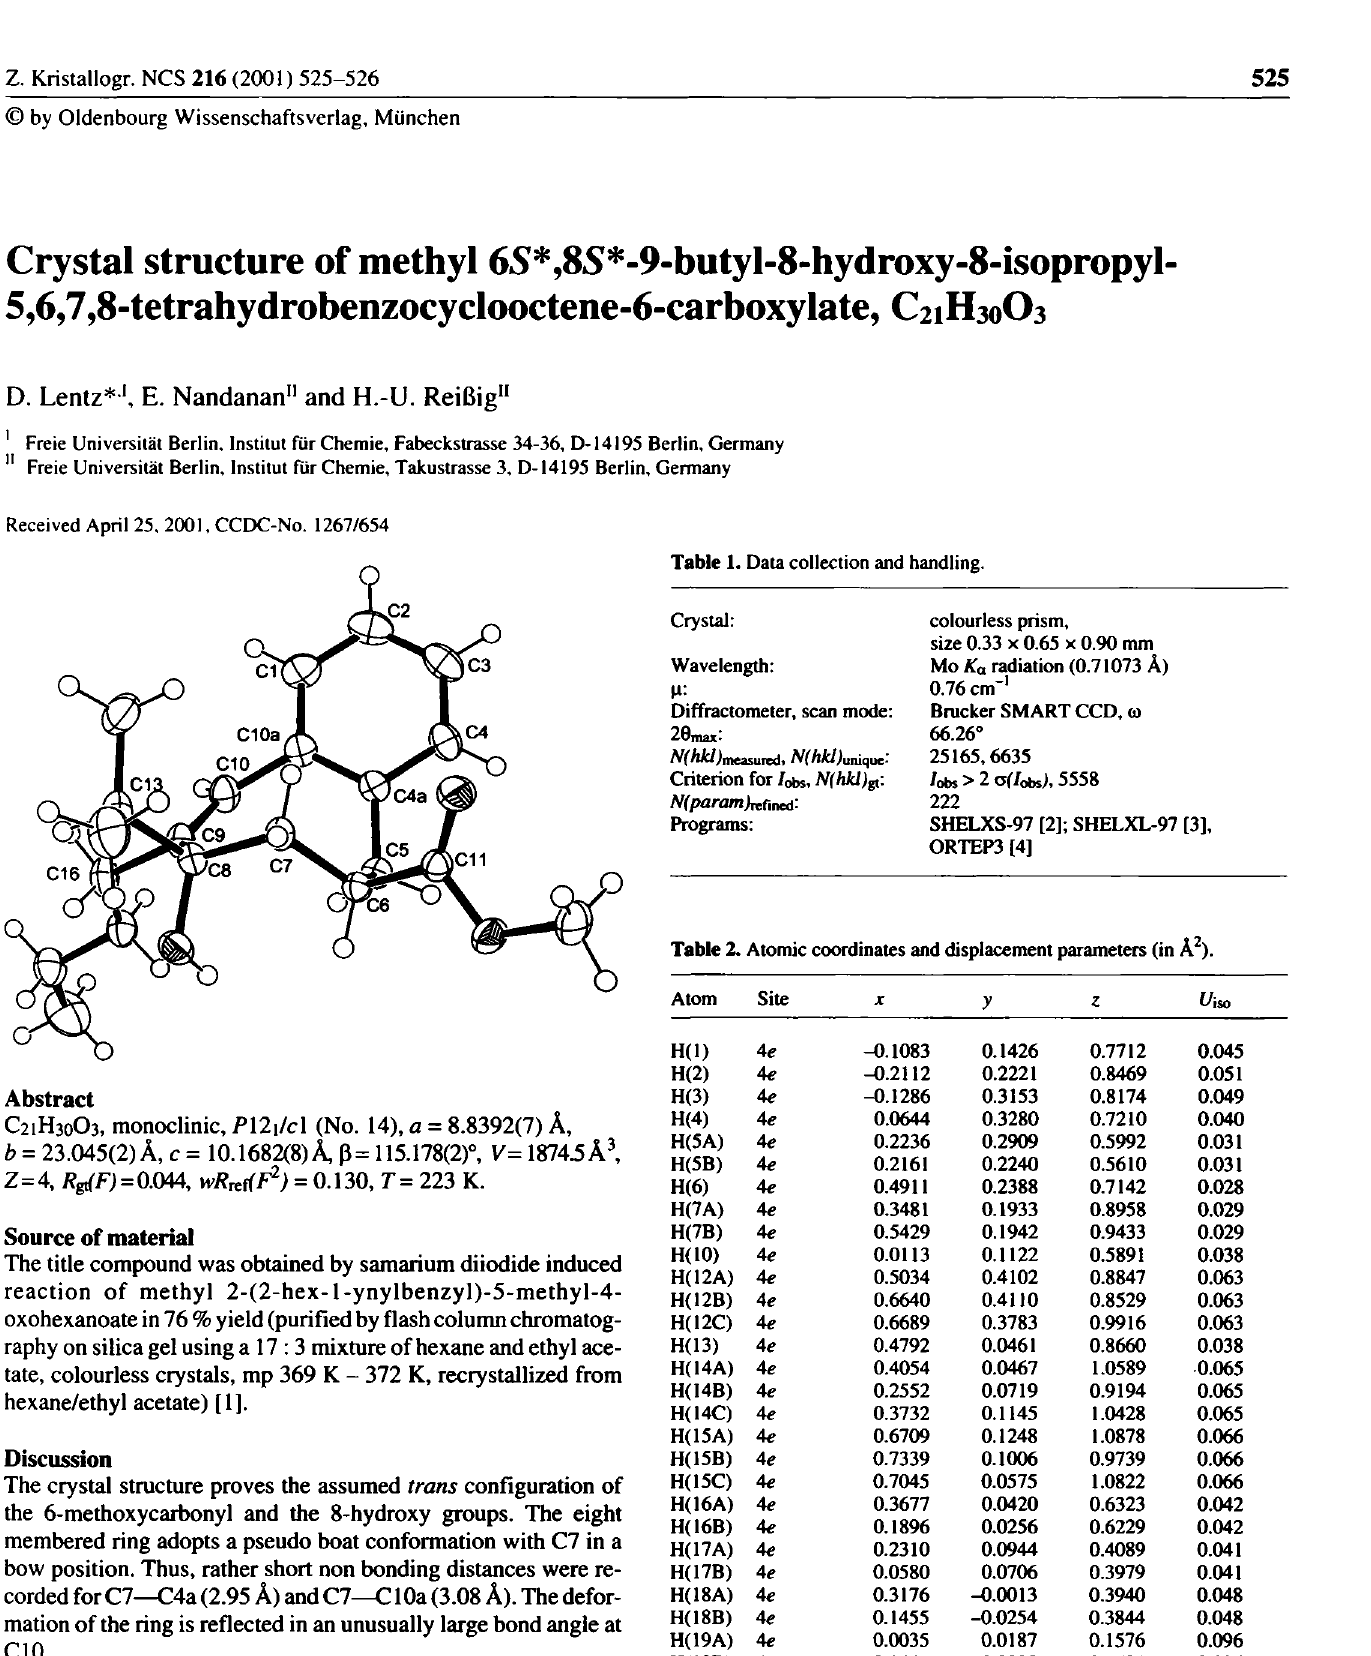
Table 2. Atomic coordinates and displacement parameters (in Ä 2